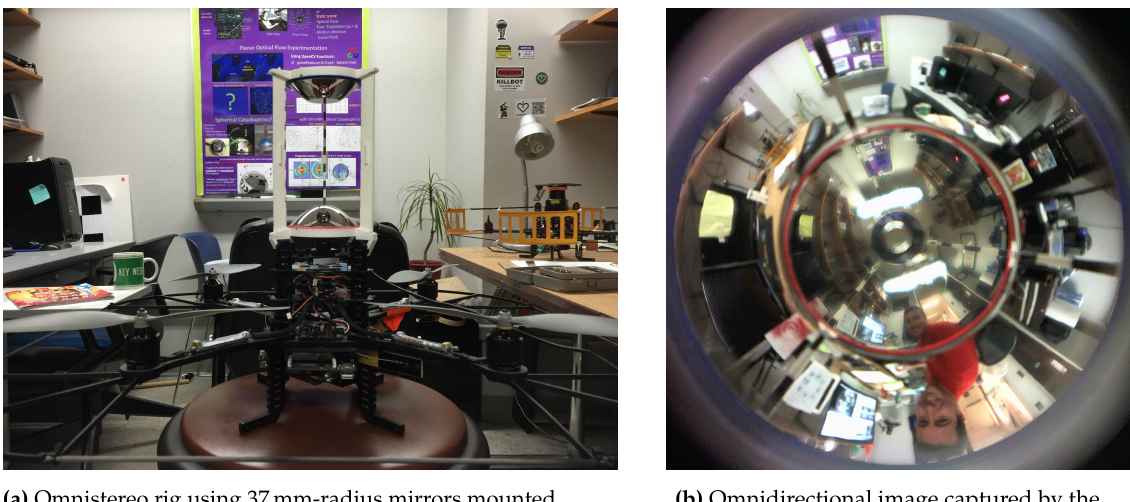
Figure 13. Real-life prototype of the omnistereo